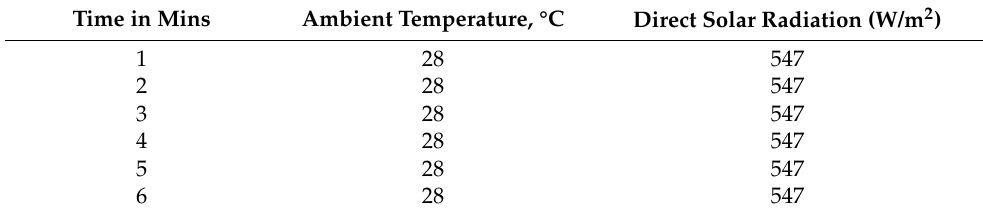
Table 1. Input data set (Kanpur). Time in Mins Ambient Temperature,